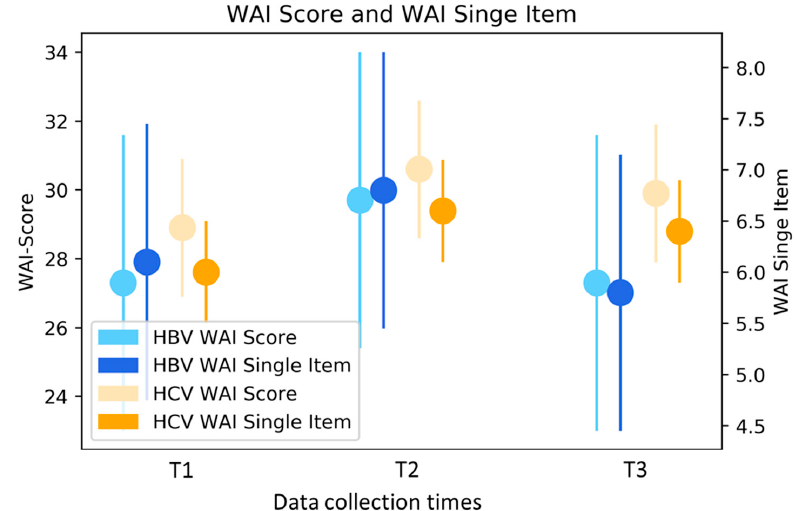
Figure 1. WAI Score and WAI Single-Item—mean values stratified by type of hepatitis and adjusted for age and gender. HBV Hepatitis B virus; HCV Hepatitis C virus; WAI Work Ability